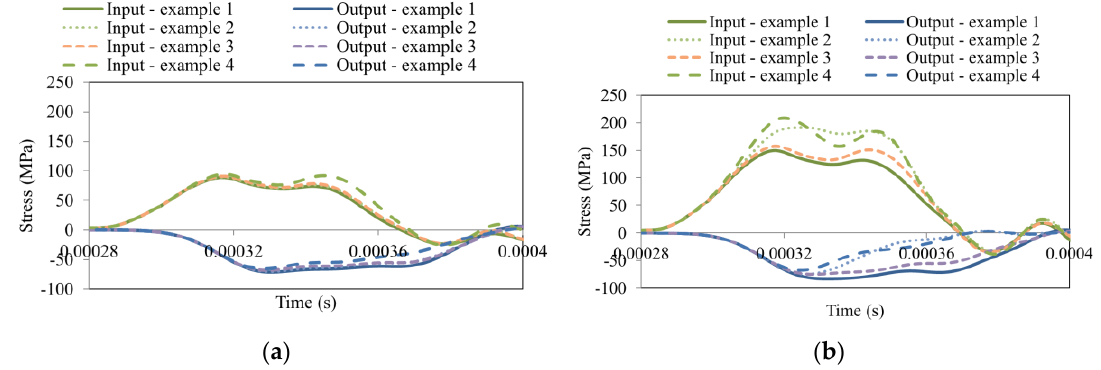
Figure 14. Parametric study concerning 𝐺 𝑓𝑐 and 𝐵 on the process of dynamic compression using SHPB for an initial impact velocity equal to ( a ) 20 m/s and ( b ) 30 m/s.